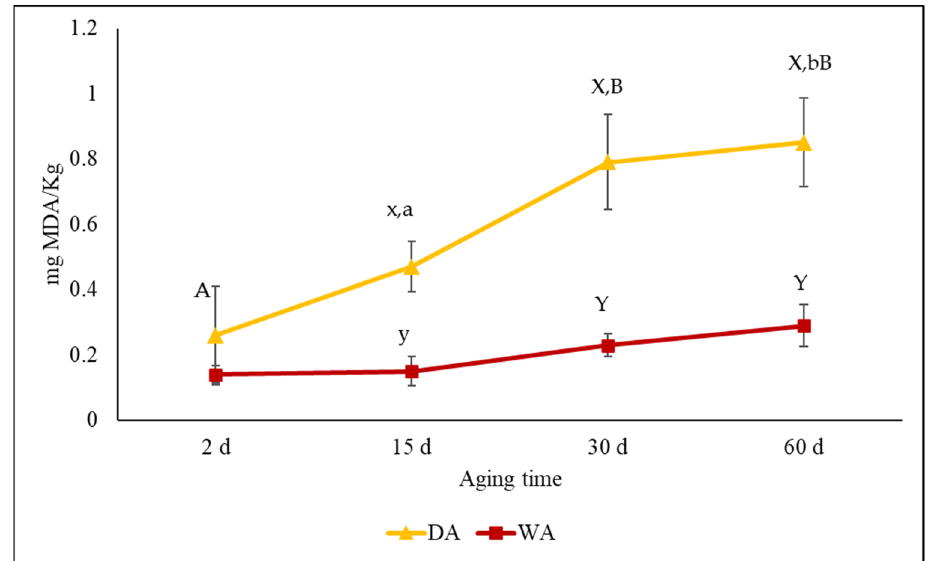
Figure 2. Changes in thiobarbituric acid reactive substances value (mg of malondialdehyde/kg) of Charolais meat cuts ( Longissimus dorsi (LD) and Semitendinosus (ST)) aged by different methods (dry ‐ aging (DA) and wet ‐ aging (WA)) for 60 days.